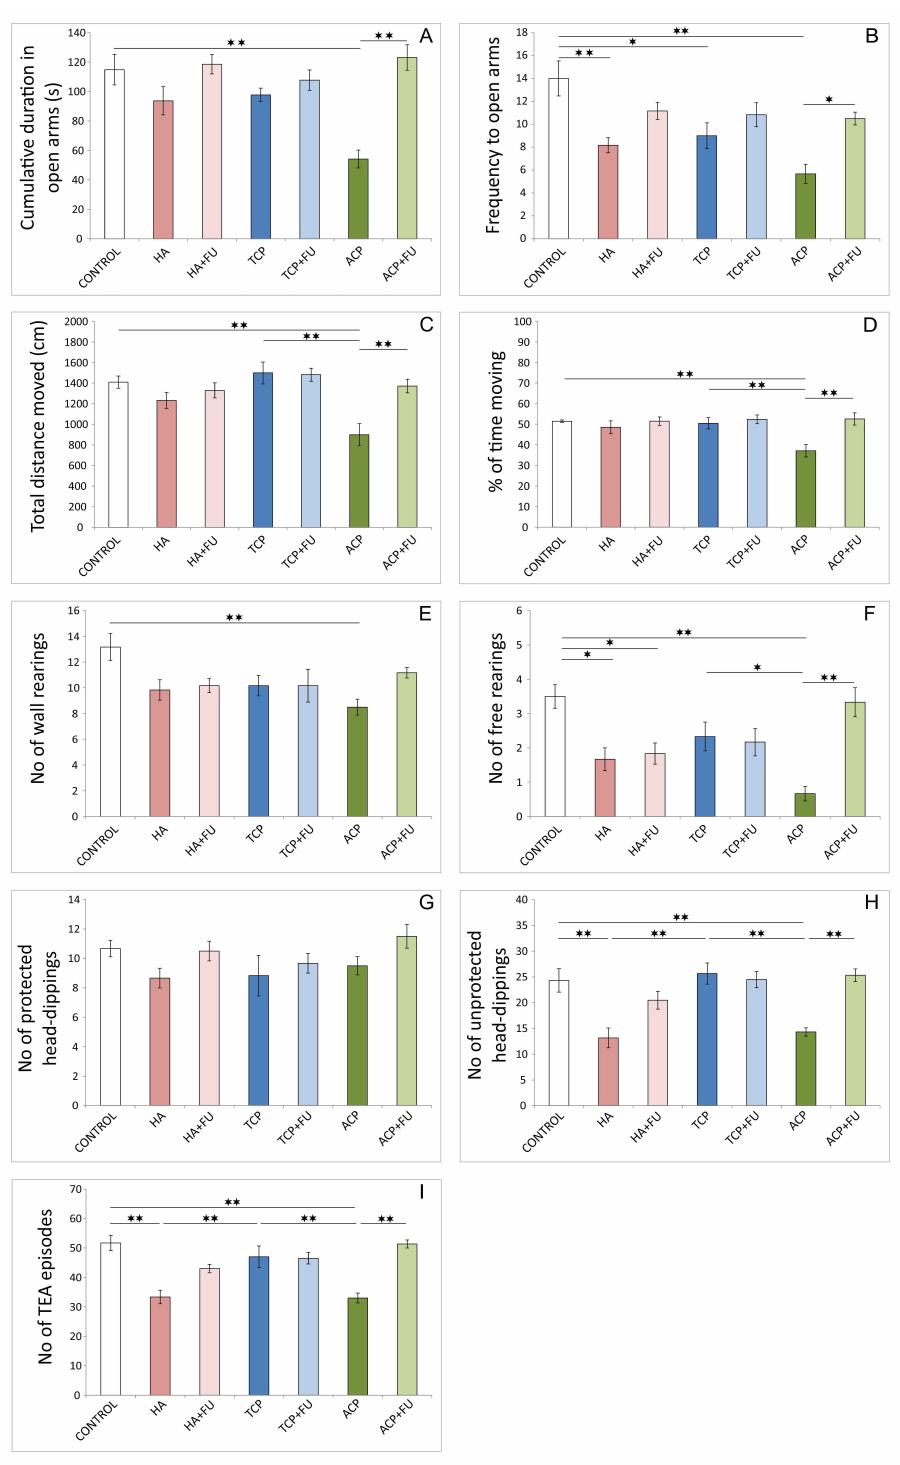
Fig. 2. Anxiety indicators were obtained in the elevated plus-maze test (6 per group). (A) Cumulative duration in open arms. (B) Frequency to open arms. (C) Total distance moved. (D) Percentage of time moving. (E) The number of free rearings. (F) The number of wall rearings. (G) The number of protected head-dippings. (H) The number of unprotected head-dippings. (I) The number of TEA (total exploratory activity) episodes. HA – hydroxyapatite; HA + FU – hydroxyapatite and Filipendula ulmaria extract; TCP – tricalcium phosphate hydrate; TCP + FU – tricalcium phosphate hydrate and Filipendula ulmaria extract; ACP – amorphous calcium phosphate; ACP + FU – amorphous calcium phosphate and Filipendula ulmaria extract. The graph bars present mean ± SEM, * represents a significant difference p < 0.05, ** represents a significant difference p <